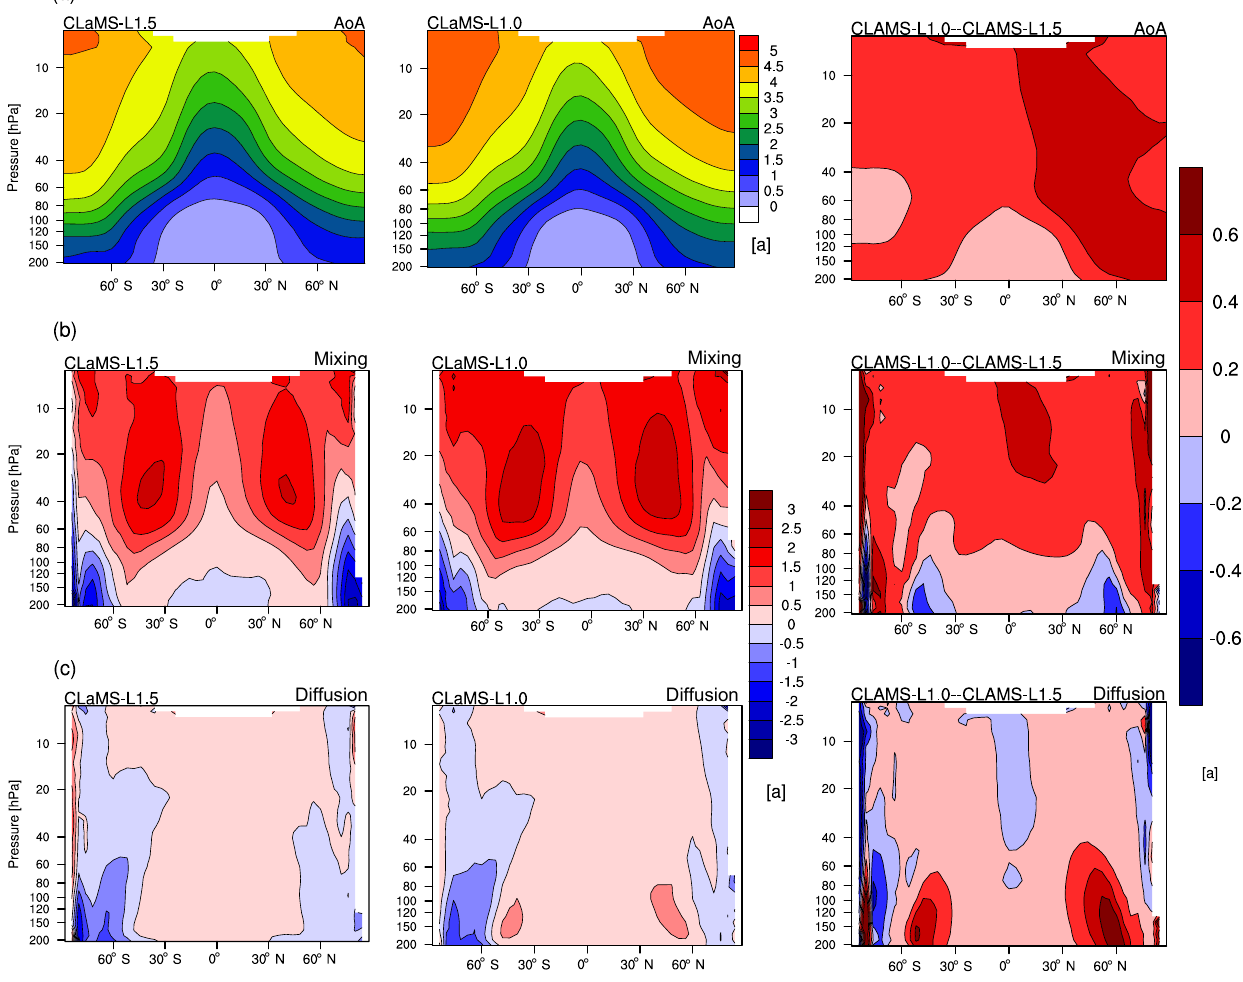
Figure 5. Sensitivity simulation with respect to mixing strength in CLaMS: zonal annual mean of (a) AoA, (b) resolved aging by mixing and (c) aging by diffusion from the years 1990 to 2010 for the simulations CLaMS-1.5 (left) and CLaMS-1.0 (middle). Moreover, respective absolute differences between CLaMS-1.0 and CLaMS-1.5 are given in the right column. Units are given in years [a]. Table 2. Mixing efficiency (cid:15) for the simulations EMAC-RC1, EMAC-RC1SD, CLaMS-ERAI and CLaMS-L1.0. Mixing efficiency is derived with the TLP model, with a tropical pipe bounded by 30 ◦ N–30 ◦ S. The upper row gives the mixing efficiency (cid:15) (AoA) using the full AoA values, the lower row the mixing efficiency (cid:15) (RCTT + aging by resolved mixing